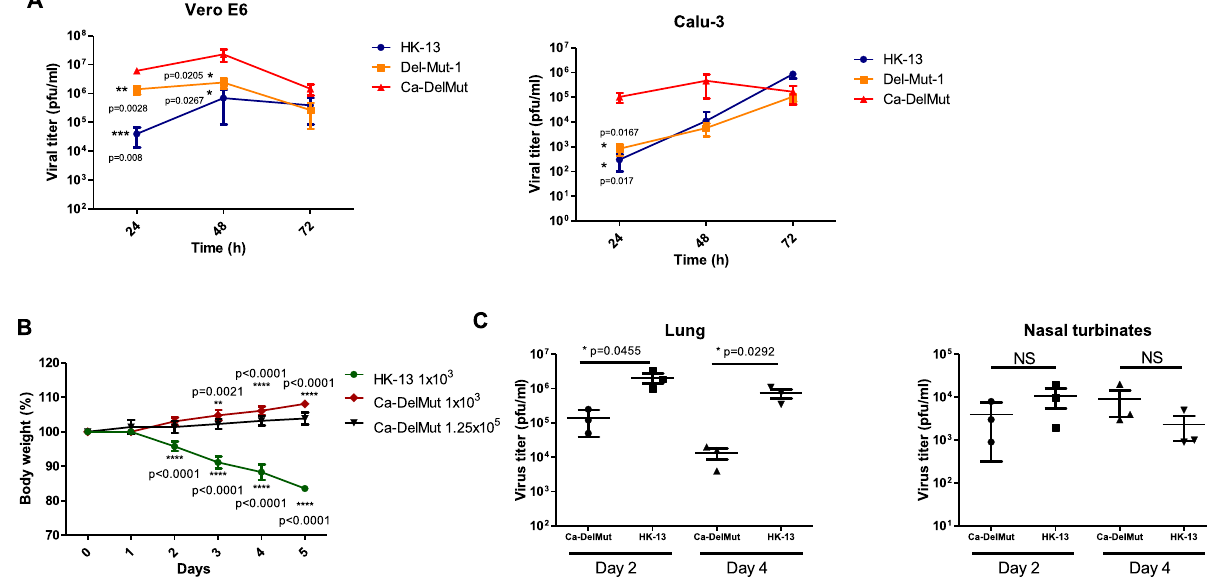
Fig. 2 Replication ef fi ciency of Ca-DelMut in vitro and in vivo. A Vero E6 or Calu-3 cells were infected with Ca-DelMut and other viruses at 0.01 MOI and cultured at 37 °C. At the indicated time points, supernatants were collected, and virus titer determined by plaque assay in Vero E6 cells. For each time points, 3 biological replicates were performed. Error bars represent mean ± SD ( n = 3). Statistical comparisons between means ( n = 3) were performed by one-way ANOVA with Tukey post-test: *** p < 0.001, ** p < 0.01, * p < 0.05. B Ca-DelMut infection in hamsters. Hamsters were infected intranasally with either Ca-DelMut ( n = 9) or wild-type (WT) ( n = 9) viruses at different doses, as indicated. Body weight was monitored for 5 days. Error bars represent mean ± SD ( n = 3). Statistical comparisons between means were performed by two-way ANOVA with Bonferroni post-test: *** p < 0.001, ** p < 0.01. C Replication of Ca-DelMut in lung and nasal turbinate tissues. After virus challenge (1 × 10 3 pfu), lung and nasal turbinate tissues were collected from hamsters at days 2 and 4, then homogenized and virus titer determined. Error bars represent mean ± SD ( n = 3). Statistical comparisons between means were performed by one-way ANOVA with Tukey post-test: ** p < 0.01, * p < 0.05, NS: not signi fi cant.